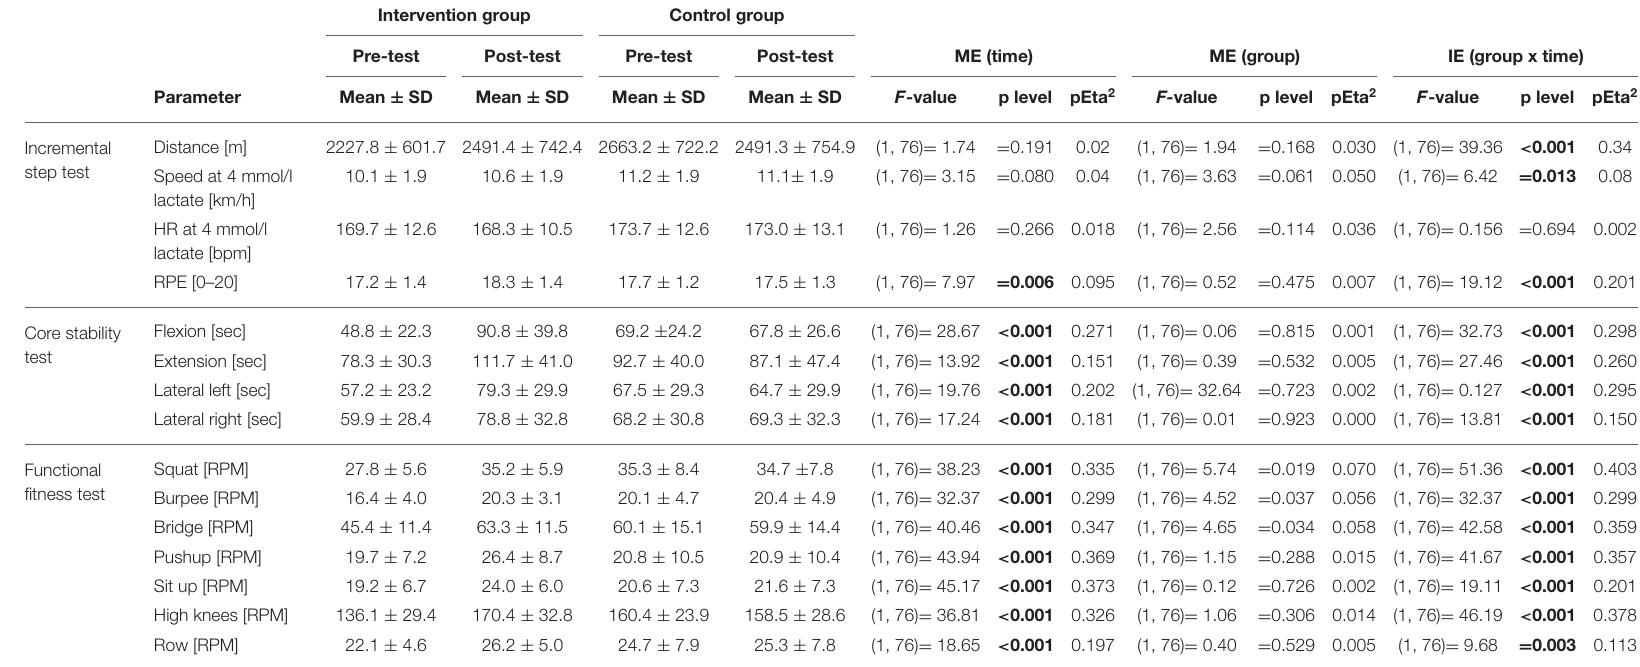
Statistics are presented for the main effects (ME) time and group and the interaction effect (IE) time × group. Bold values indicate significant differences for main effects and/or